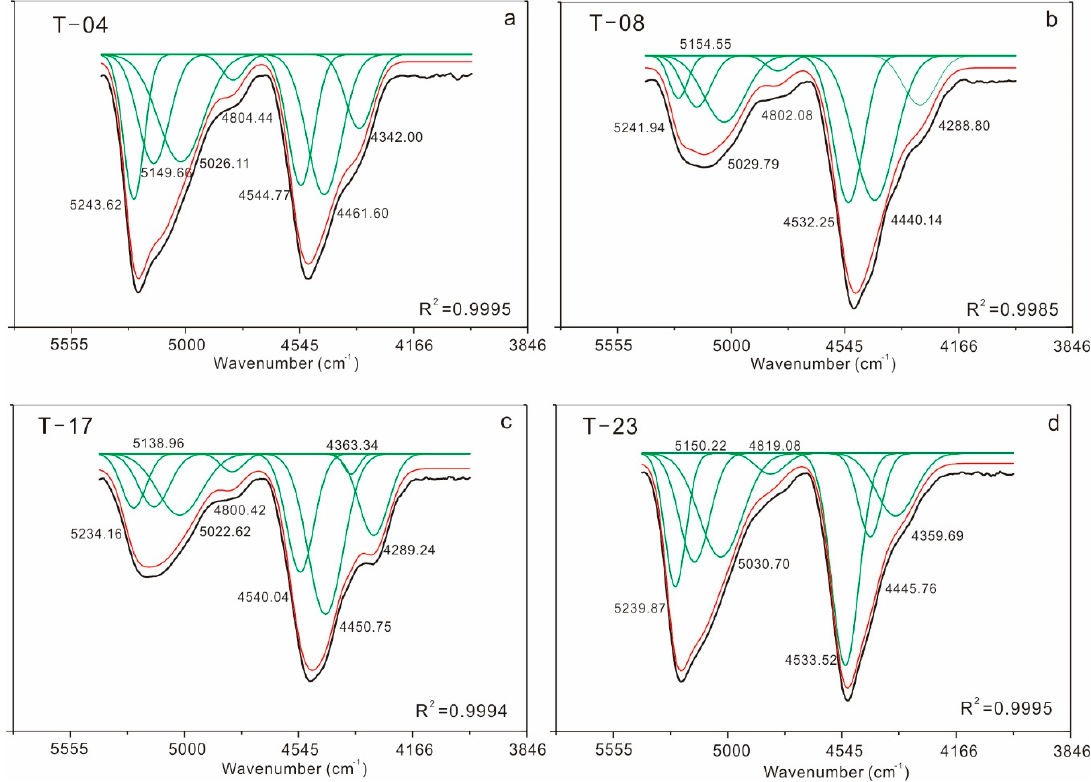
Figure 6. Decomposition of the NIR combination bands of four samples ( a ) T-04, ( b ) T-08, ( c ) T-17, and ( d ) T-23. Black line: experimental; green line: fit and diagnostic bands.